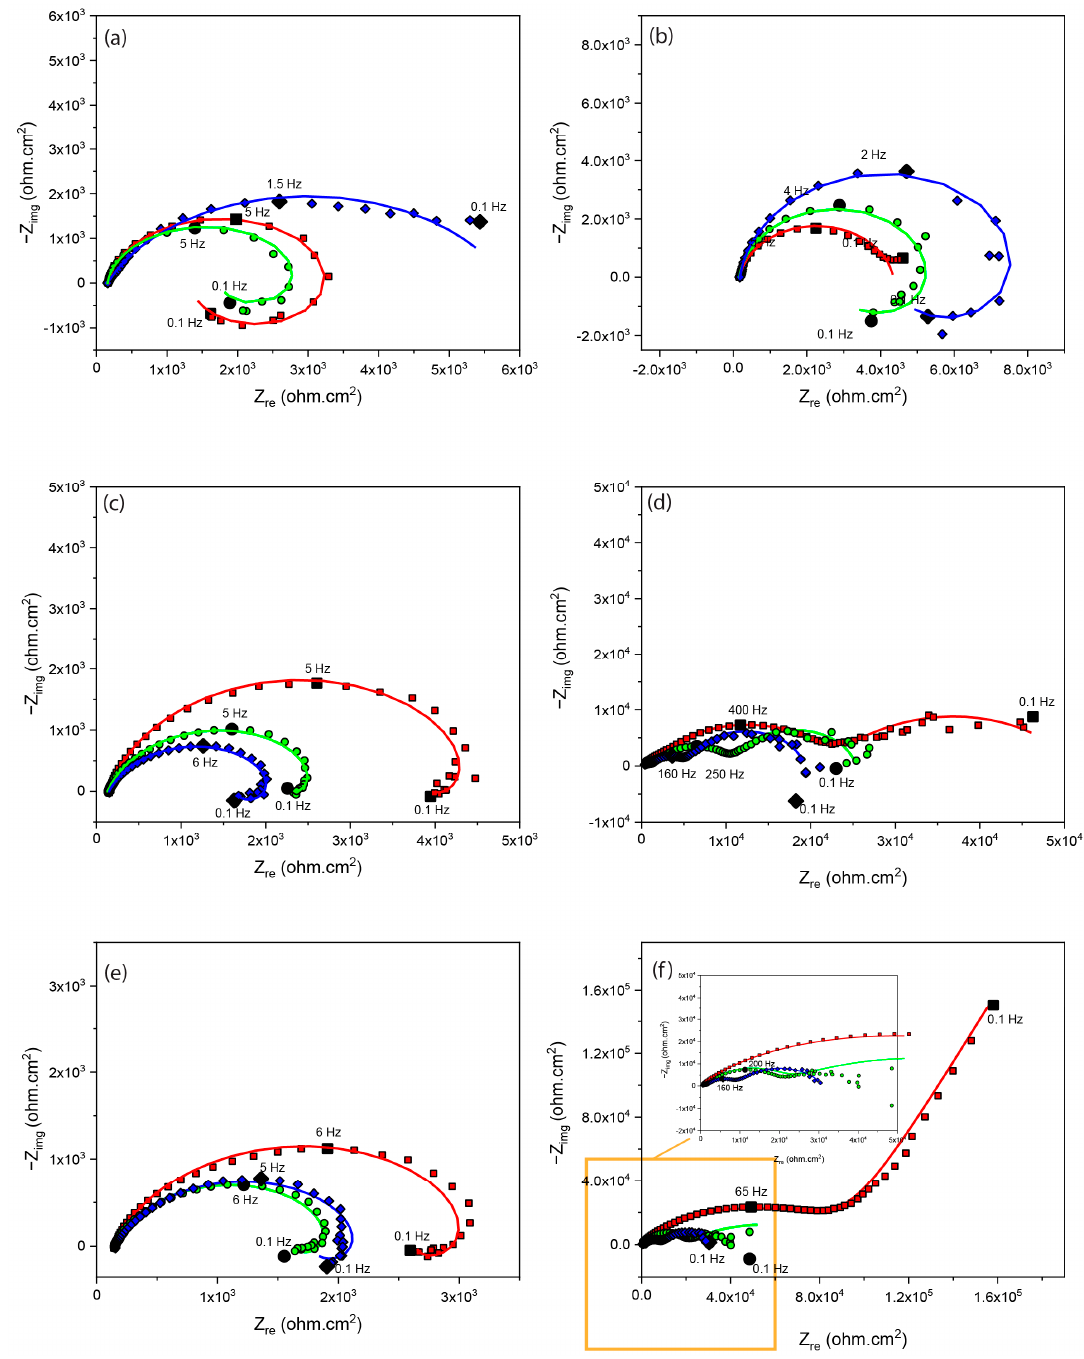
Figure 12. Nyquist plots of ( a ) the etched substrate, ( b ) anodized substrate, ( c ) E1024, ( d ) E1124, ( e ) A1024, and ( f ) A1124, after immersion in 0.1 NaCl for 1 h, 6 h, and 24 h. The time constant at the low frequency of the Bode and Nyquist phase diagrams shows the inductive loop which is due to the adsorption and coverage of Mg ions, involving monovalent and divalent ions, on the surface of etched, anodized, E1024, and A1024 substrates. For these samples, after 6 and 24 h of immersion, the inductive loop still existed, which points out the poor protective properties of the LDH layer. According to the literature, this loop is attributed to the high concentration of magnesium ions in relatively film-free areas or the relaxation of Mg(OH) + , and Mg + absorbed at the surface [42–44]. The other time constant for these samples at medium frequency is a capacitance loop with